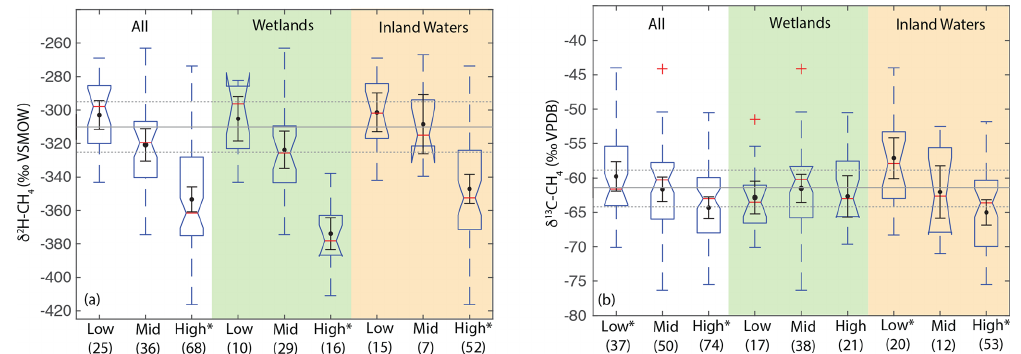
Figure 7. Boxplots of (a) δ 2 H–CH 4 and (b) δ 13 C-CH 4 for sites differentiated by latitude, for all data, wetlands, and inland waters. Numbers in parentheses indicate the number of sites for each category. Red lines indicate medians, boxes indicate 25th and 75th percentiles, whiskers indicate 95th and 5th percentiles, and outliers are shown as red crosses. Notches indicate the 95% confidence intervals of the median value; where notches overlap the edges of the box this indicates the median confidence interval exceeds the 75th or 25th percentile. Black points and error bars indicate the category mean and 95% confidence interval of the mean. Grey lines indicate the estimated flux-weighted mean values for global freshwater CH 4 , and dashed lines indicate the 95% confidence interval of this value. Asterisks in (a) indicate that high-latitude sites have significantly different distributions from other latitudinal bands. Asterisks in (b) indicate groups that have significantly different distributions from one another, within a specific environmental category. Two extremely low outliers ( < − 80‰; high-latitude wetland and inland water) are not shown in (b) .